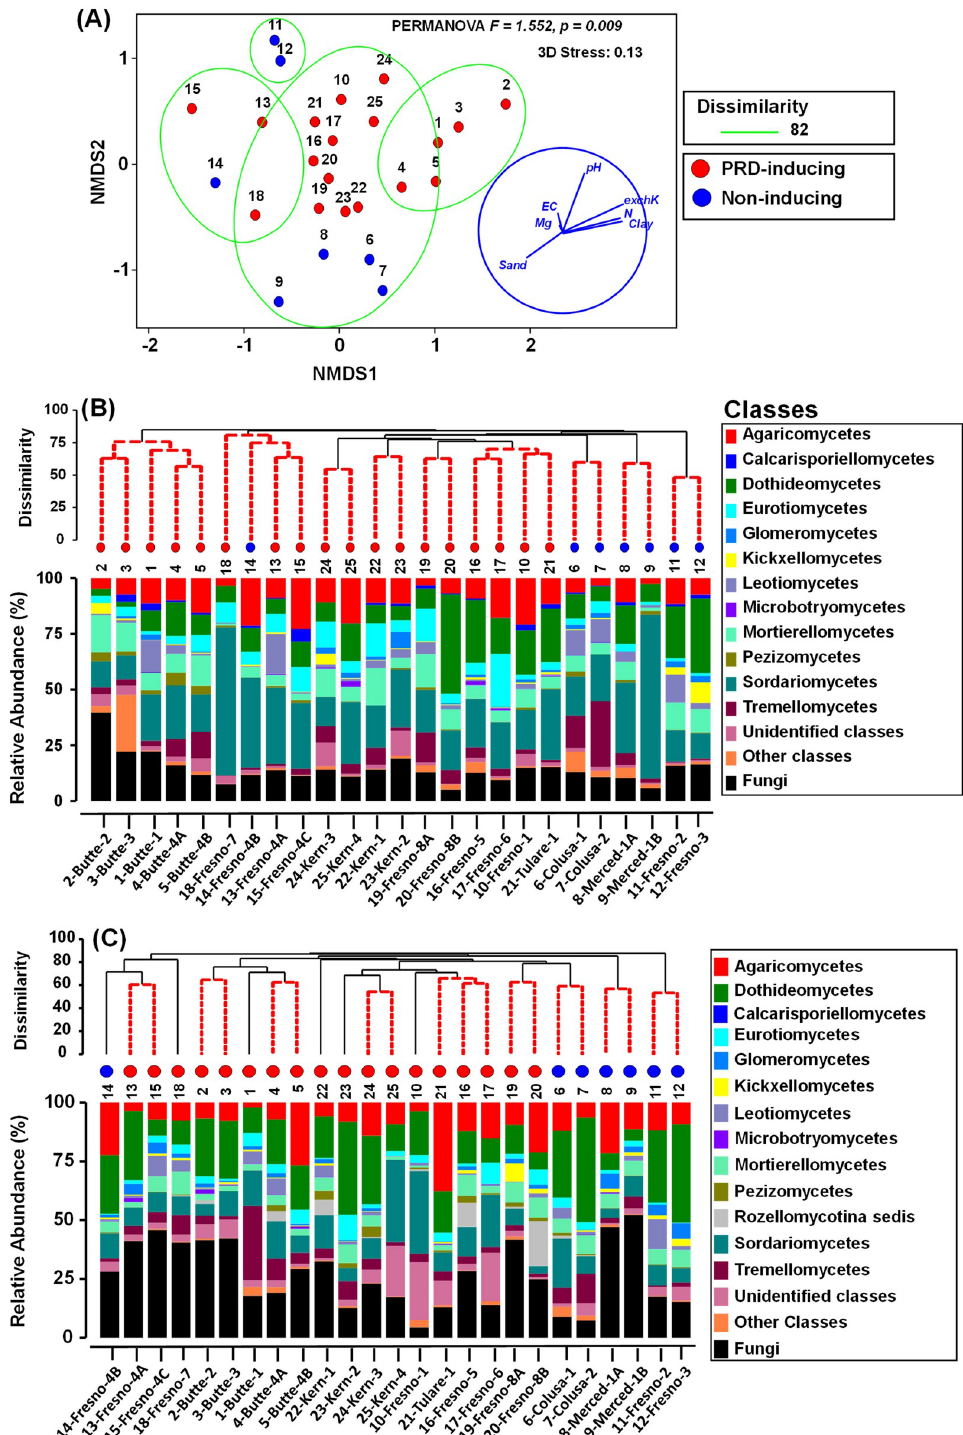
Fig 4. Characterization of soil fungal community relationships and composition among PRD-inducing and non- inducing soils. (A) Non-metric multidimensional scaling (NMDS) ordination of soils based on Bray Curtis dissimilarity matrix (with overlays of hierarchical clustering at dissimilarity levels of 82% delimited by green lines and physicochemical vector relationships); (B) hierarchical clustering of soils based on BC-dissimilarity and class-level fungal community composition of ITS1 amplicons; and (C) hierarchal clustering of soils based on BC-dissimilarity and class-